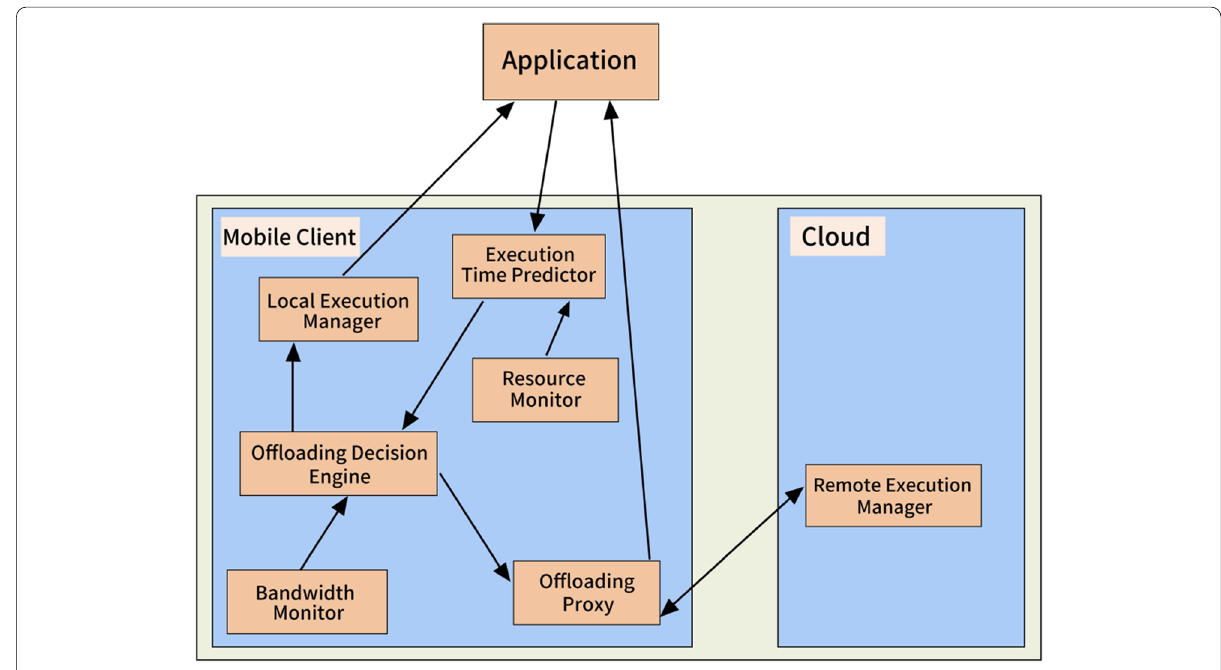
Fig. 5 Architecture of Phone2Cloud. (Feng et al.